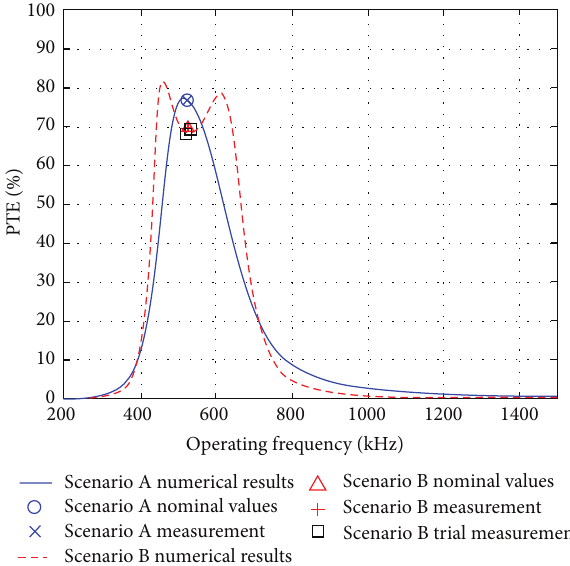
Figure 8: PTE versus operating frequency for two different DCR configuration scenarios.